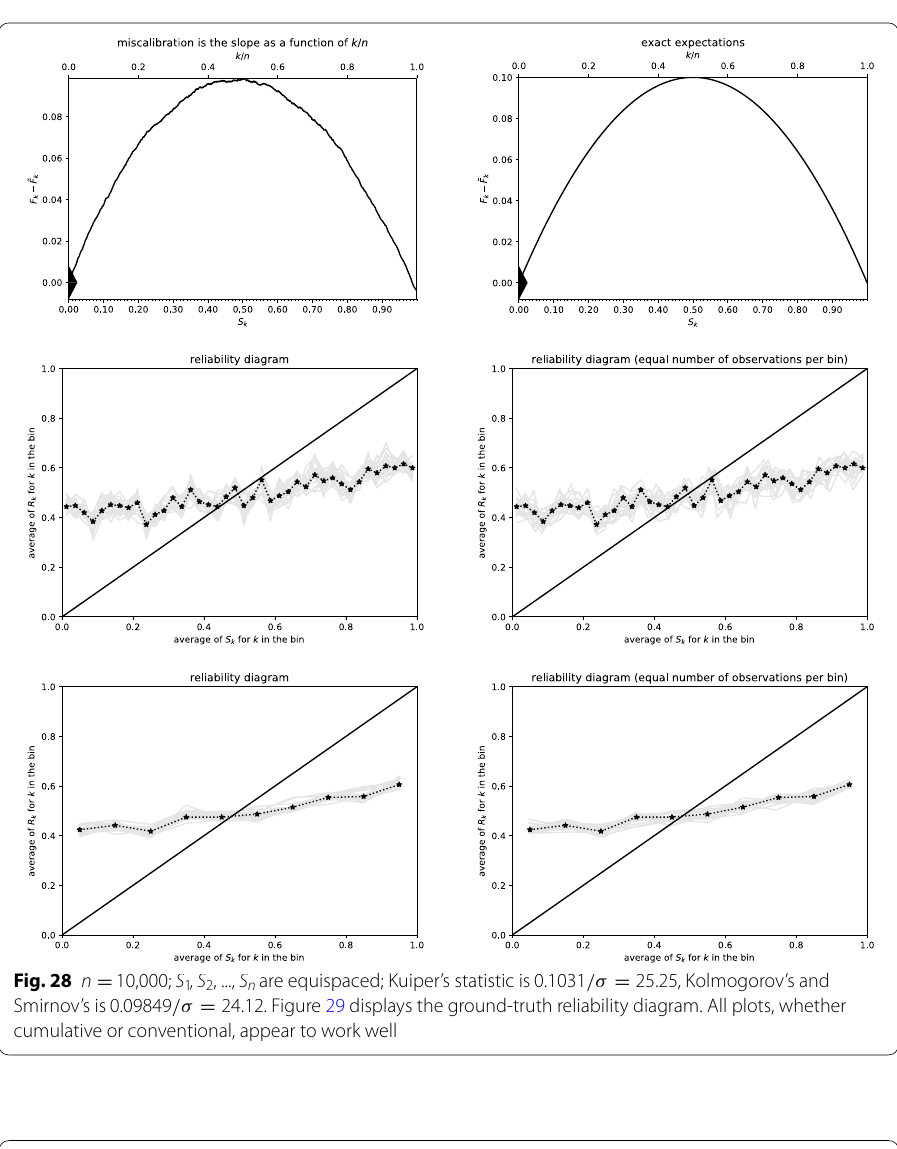
Fig. 28 n = 10,000; S 1 , S 2 , ..., S n are equispaced; Kuiper’s statistic is 0.1031 /σ = 25.25 , Kolmogorov’s and Smirnov’s is 0.09849 /σ = 24.12 . Figure 29 displays the ground-truth reliability diagram. All plots, whether cumulative or conventional, appear to work well